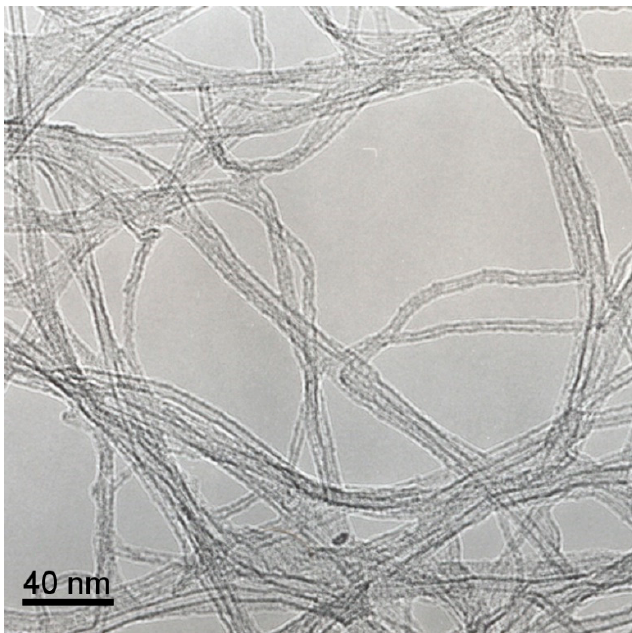
Figure 8. TEM image of SWNTs selectively grown on TiN surface.